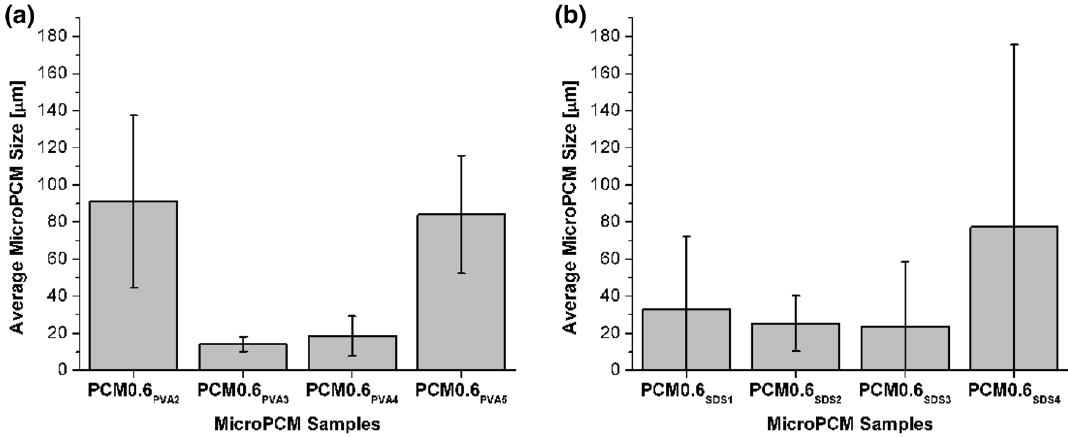
Fig. 8 Effects of emulsifier type and content on microPCM’s sizes: a PVA and b